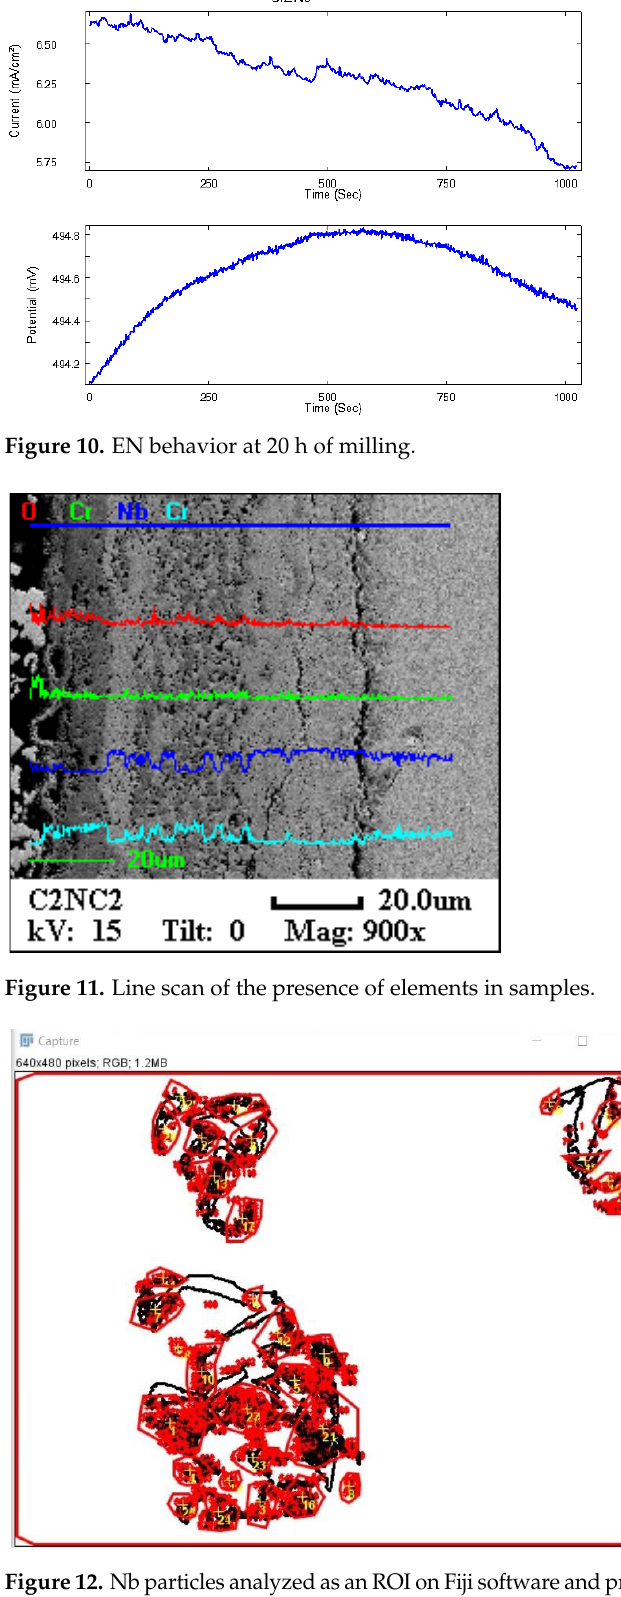
Figure 9. EN behavior at 8 h of milling.